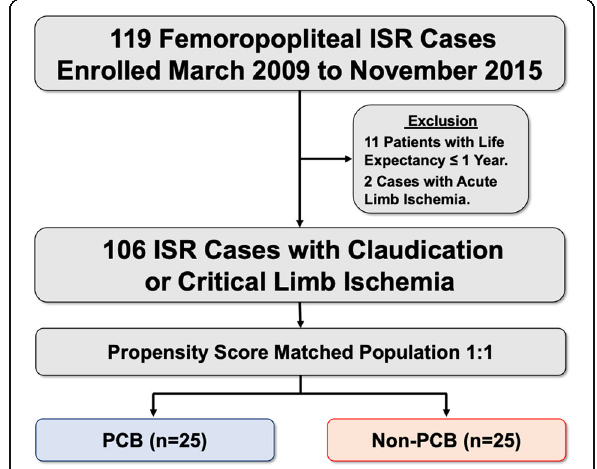
Fig. 1 Study Flow chart. ISR indicates in-stent restenosis; PCB, paclitaxel-coated